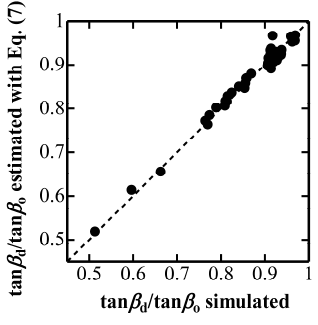
Figure 5. Degree of change in inclined face angle tan β d /tan β o estimated with Equation (7) plotted against tan β d /tan β o observed in simulated nanoindentation. E d05.1* E The representative indentation elastic modulus E *, defined as 2 tan225.01 in terms of β d [9], can be estimated from the simulated P - h curve using Equations (3)–(7) if we know E i and ν i , whereas it is evaluated with E and ν inputted into the FEM model and with β d observed in simulated nanoindentations. Figure 6 plots the estimated E * (black circles) against the evaluated E *. The white circles are E * n estimated with the nominal values of k 2n and ξ n [9], which means that the elastic deformation of an indenter is not modified for the estimation of E *. Figure 6 indicates the modification of the elastic deformation of an indenter can determine E * correctly. The underestimation of E * without the modification (the white circles in Figure 6) is caused by the overestimation of the elastic rebound during the unloading process because the extrinsic elastic deformation of the indenter is added to the intrinsic elastic deformation of the indented material.